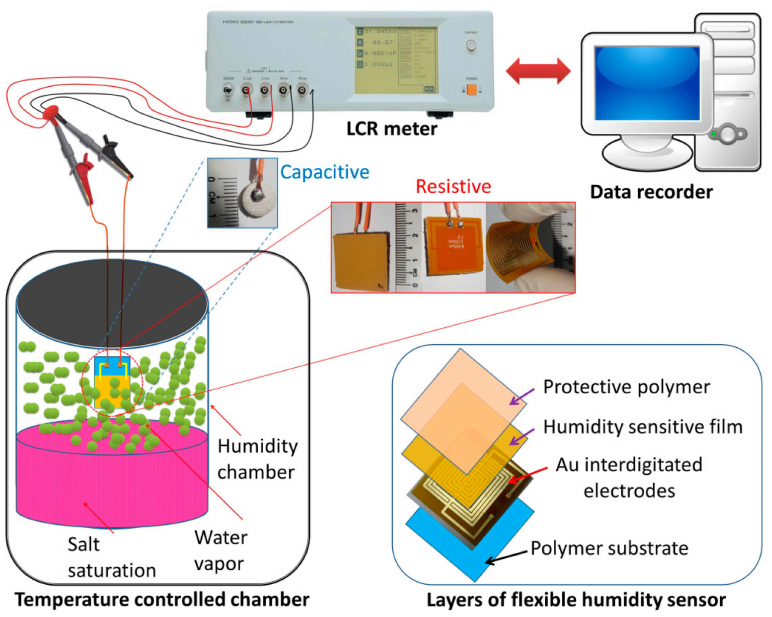
Figure 1. Schematic representation of capacitive- or resistive-type humidity sensors and measurement